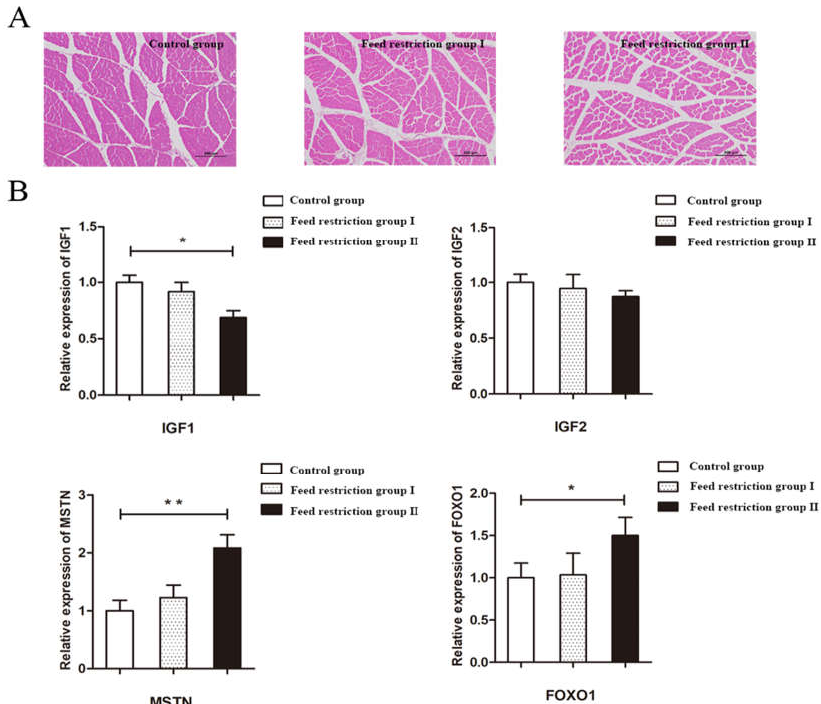
Figure 1. The HE staining image and effect of feed restriction associated with skeletal muscle development. ( A ) the HE staining image of the skeletal muscle of the control group, the restricted-feeding group I, and the restricted-feeding group II, respectively; ( B ) effect of feed restriction on the expression level of genes associated with skeletal muscle development; * indicated significant difference ( p < 0.05); ** indicated extremely significant difference ( p < 0.01). Table 10. ANOVA of the area of the skeletal muscle fibers.